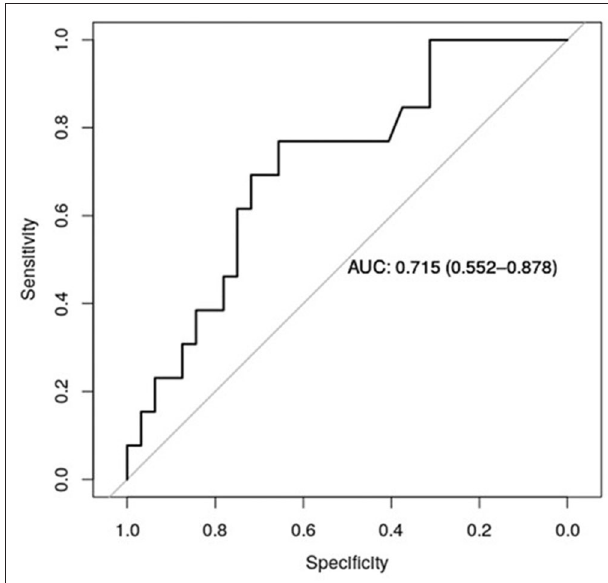
FIGURE 5 | ROC curve for claudin-7 and site of metastases. The figure show the ability of claudin-7 mRNA to distinguish patients with distant hematogenous metastases from transcoelomic/lymphatic metastases. The calculated AUC is 0.715 (95% CI, 0.55–0.88).